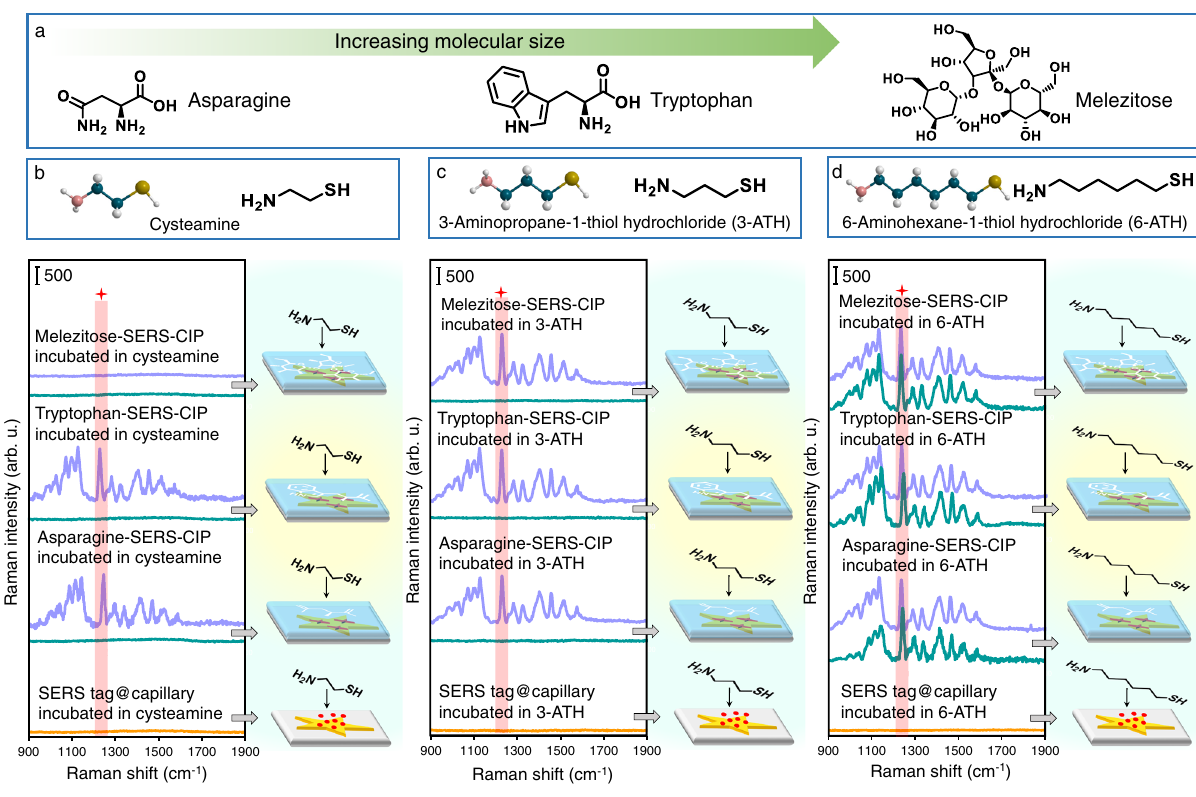
Fig.5|VersatilityoftheIRM.a Chemicalstructureofasparagine,tryptophan,and melezitose. Raman spectra of DTTC on different platforms, including SERS tag@-